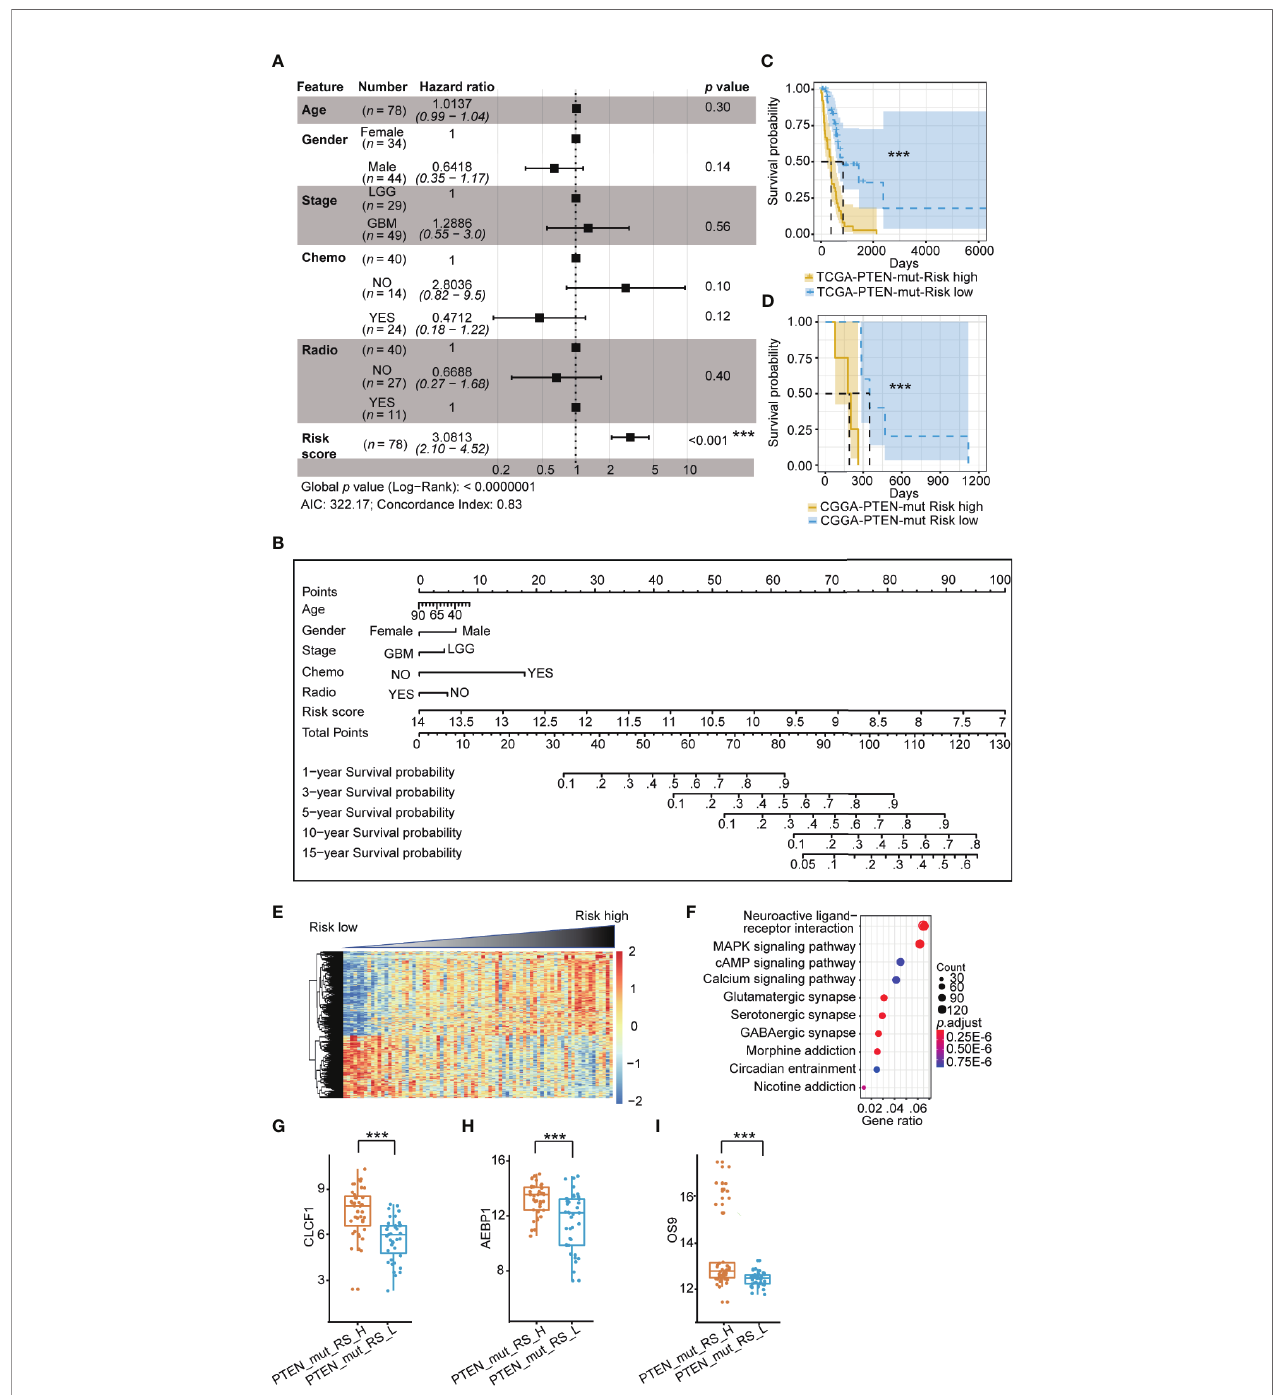
FIGURE 4 | Prognostic risk model in TCGA PTEN-mut subgroup: (A) Multivariate Cox forest plot of risk score and clinical feature in TCGA PTEN-mut subgroup ( n = 78 , AIC = 322.17, C-index = 0.83); (B) A nomogram incorporating risk score based on 11 OPR-DEGs ( Supplementary Table 7 , risk score in Supplementary Table 1 ) and clinical features in TCGA PTEN-mut subgroup; (C) Survival analysis (Kaplan Meier Curve) of high-risk score patients (PTEN_mut_RS_H, blue, n = 39) and low-risk score patients (PTEN_mut_RS_L, yellow, n = 39) in TCGA PTEN-mut subgroup (high-risk score and low-risk score separated from the median risk score of TCGA PTEN-mut subgroup); (D) Survival analysis of high-risk score patients (blue, n = 5) and low-risk score patients (yellow, n = 4) in CGGA PTEN-mut subgroup (high-risk score and low-risk score separated from the median risk score of CGGA PTEN-mut subgroup); (E) The heatmap of expression of DEGs (n =